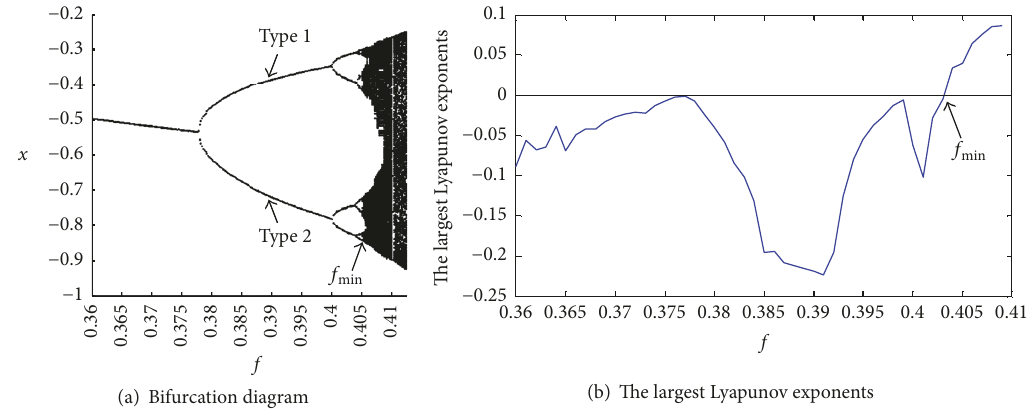
Figure 1: The system responses for different excitation amplitude 𝑓